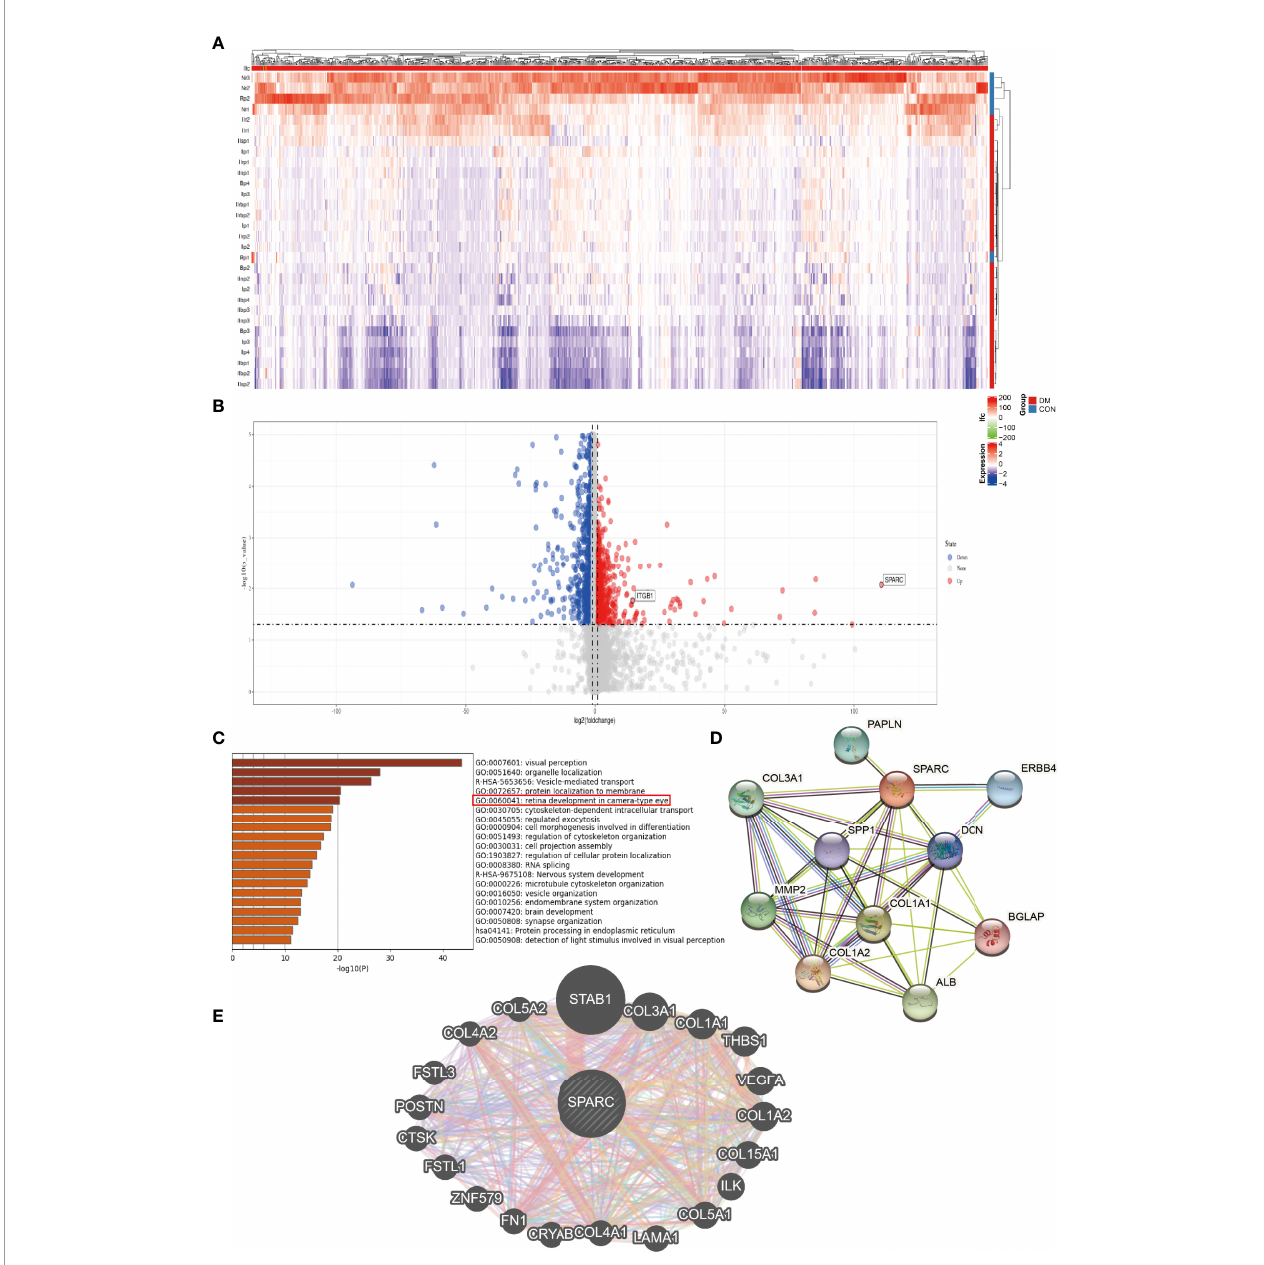
FIGURE 2 | The bioinformation analysis by GEO dataset. (A) Heatmap of DR patient. (B) Volcano map of DR patient. (C) GO pathway signaling. (D) Protein – protein network by the STRING analysis. (E) Target gene network by the GeneMANIA